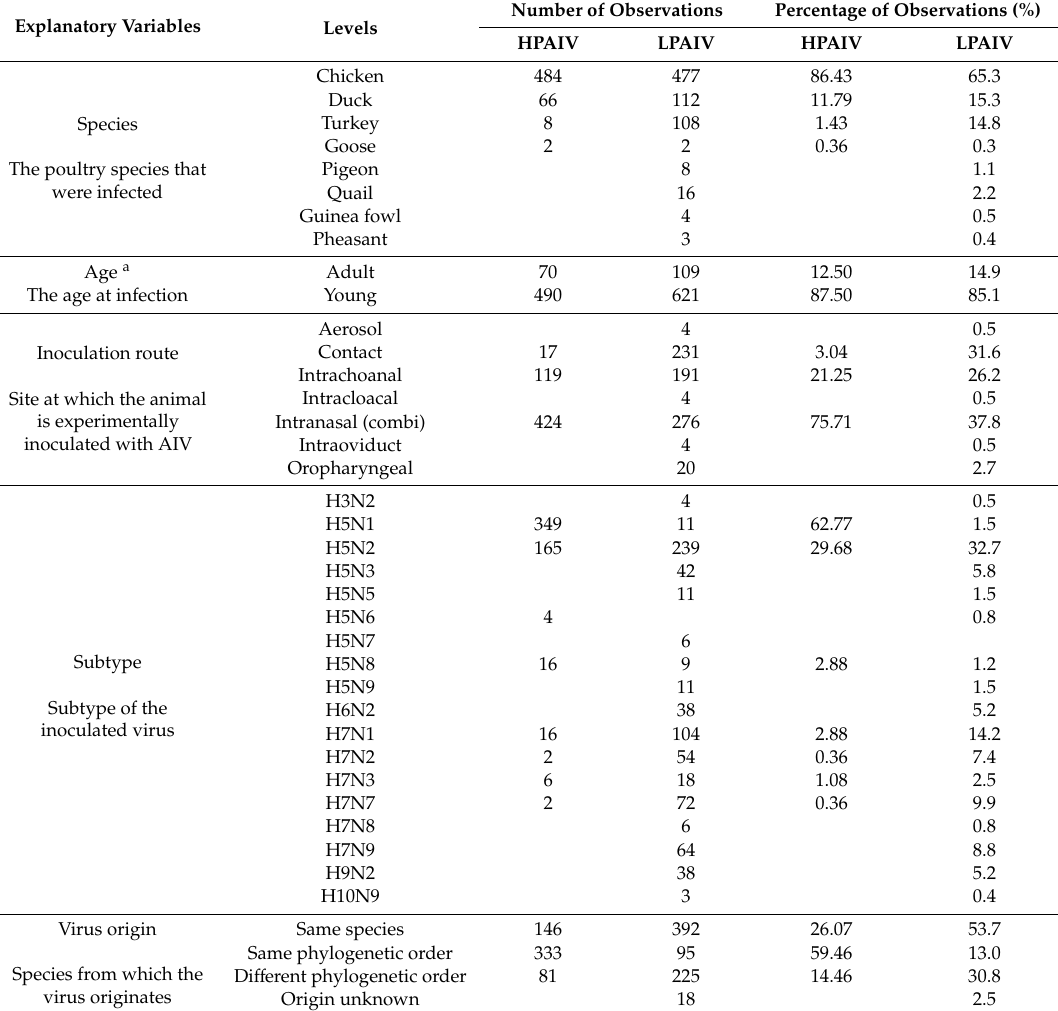
Table 1. Available data extracted from the included studies ( n = 71) used for the meta-analysis. Explanatory Variables